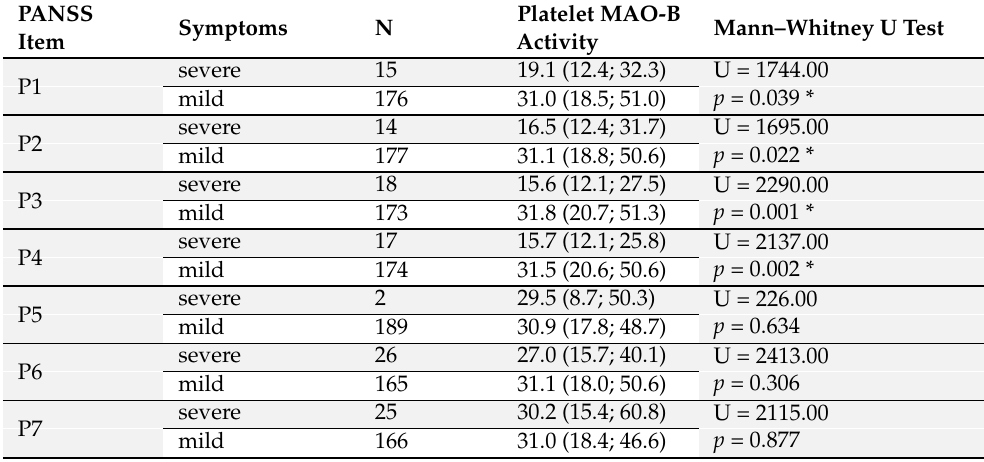
Table 4. Platelet MAO-B activity in non-smokers with PTSD subdivided into those with severe or mild PANSS individual